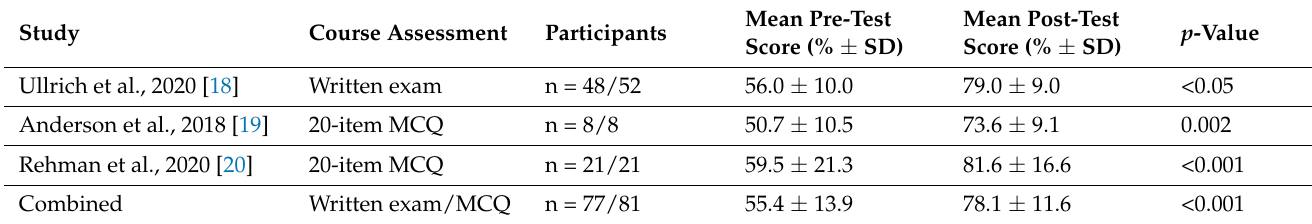
Table 4. Test Scores (Mean ± Standard